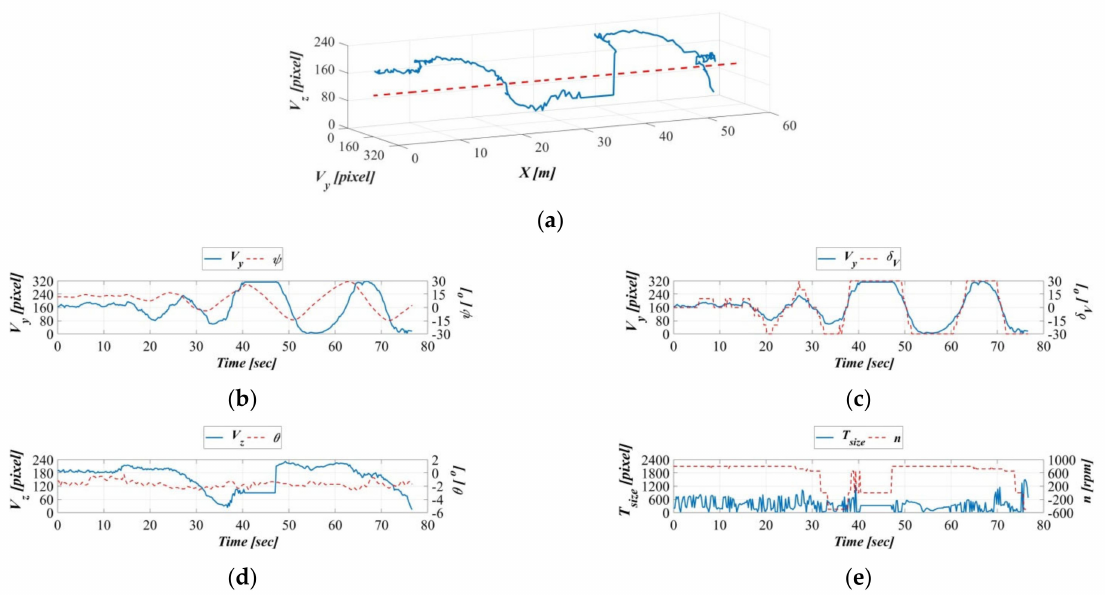
Figure 19. Dynamic guidance experiment with a towing speed of 0.8 m/s. ( a ) Displacement trajectory on the image coordinates, ( b ) time series of the image coordinate Y − axis and AUV yaw angle, ( c ) time series of image coordinate Y − axis and AUV vertical rudder, ( d ) time series of the image coordinate Z − axis and the AUV vertical rudder, and ( e ) time series of the image coordinate surface area and the AUV propeller revolution